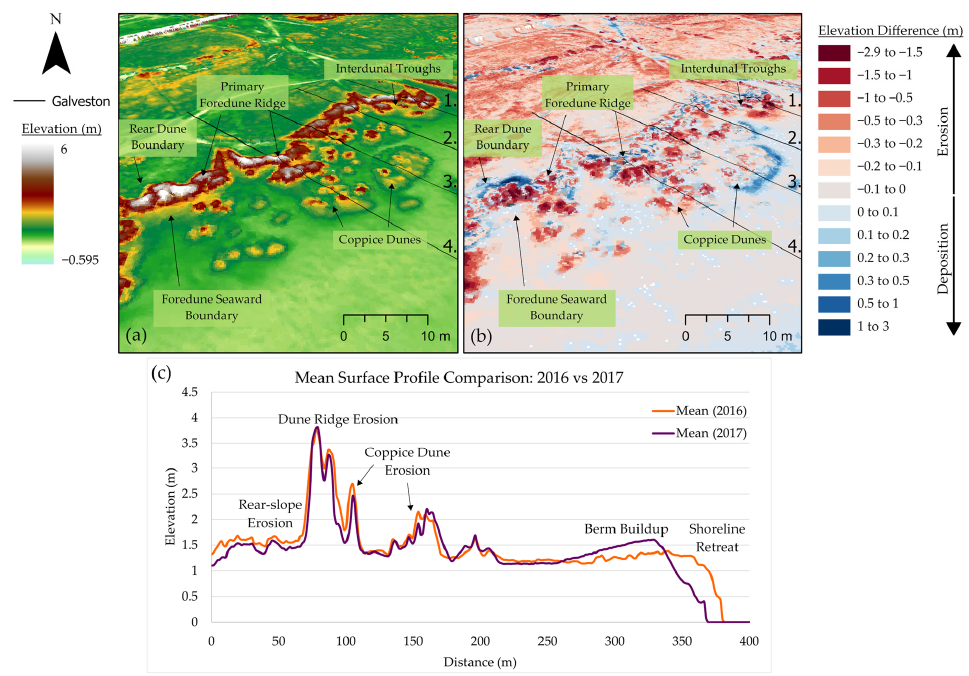
Figure 12. 3D models of Galveston Site. ( a ) A 3D model of 2016 USACE’s edited topobathy lidar- derived DEM with 4 shore perpendicular transects used to compare pre- and post- storm beach profiles within the Galveston Site; ( b ) DEM Difference Map was created using USACE’s 2016 and BEG’s 2017 surface elevation data draped over the 2016 elevation model to show changes to the site after Harvey. ( c ) The 2016 and 2017 mean profiles for transect 3 overlayed for comparison .